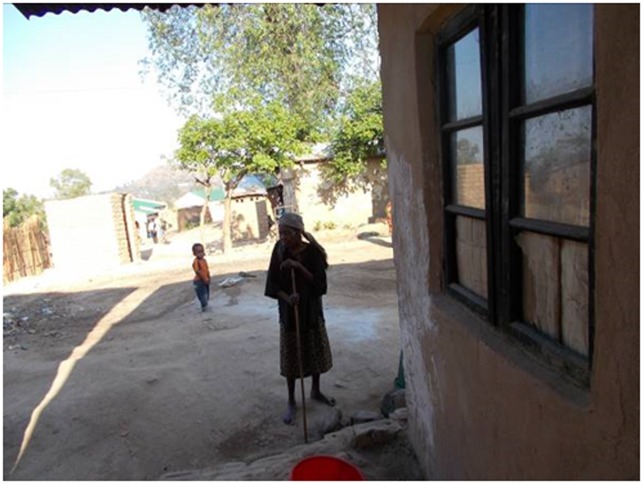
What is a good day?